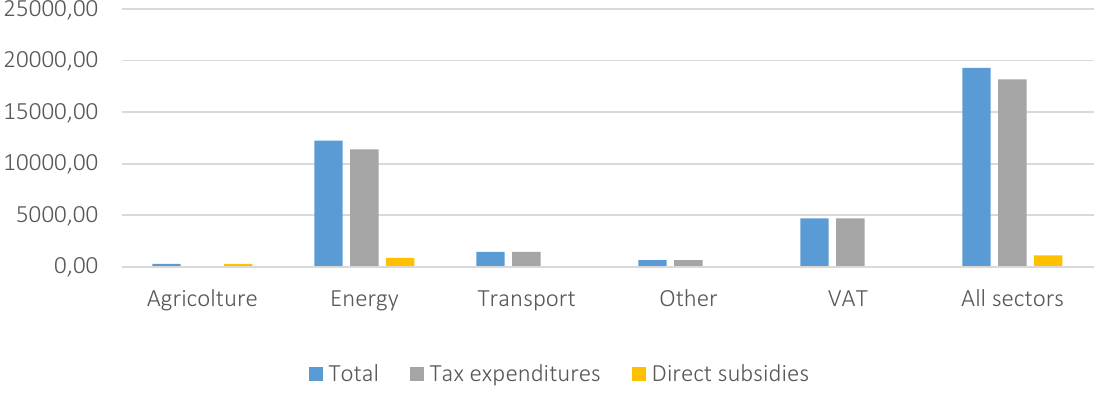
Figure 5. Environmentally-harmful subsidies (EHS) by sector and typology (2017), EUR